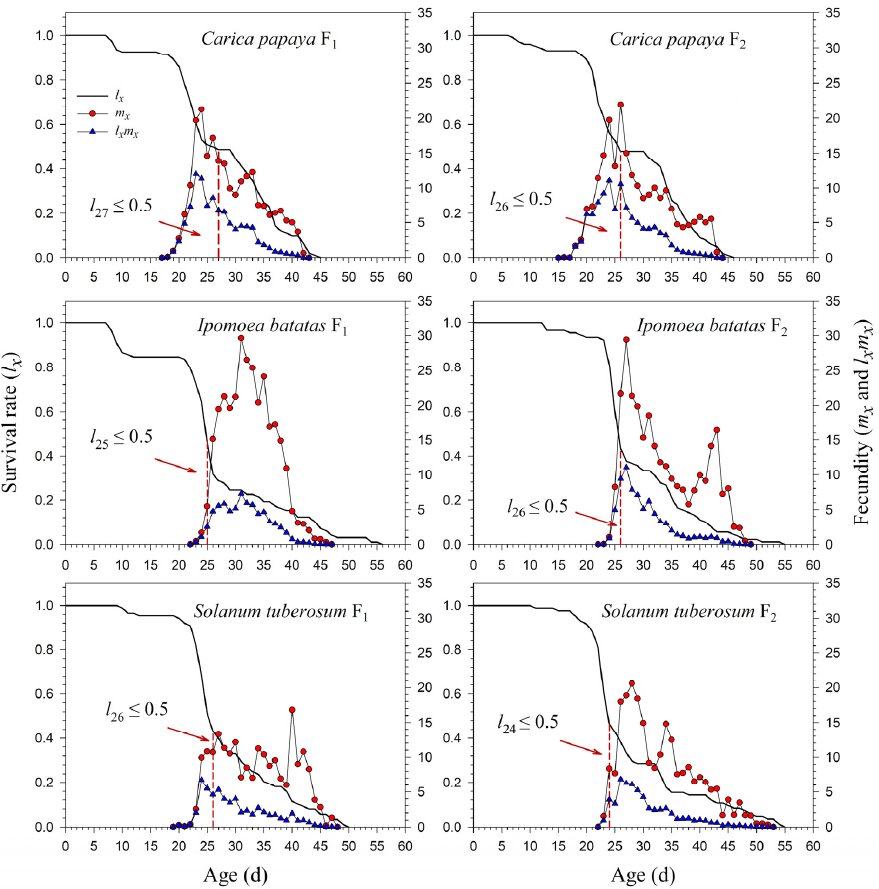
Figure 4. Age-specific survival ( l x ), fecundity ( m x ), and net maternity ( l x m x ) rates of Paracoccus marginatus individuals reared on three different host plants (F 1 –F 2 ). The red vertical dashed lines in the figure denote the age at which the survival rate l x ≤ 0.5.